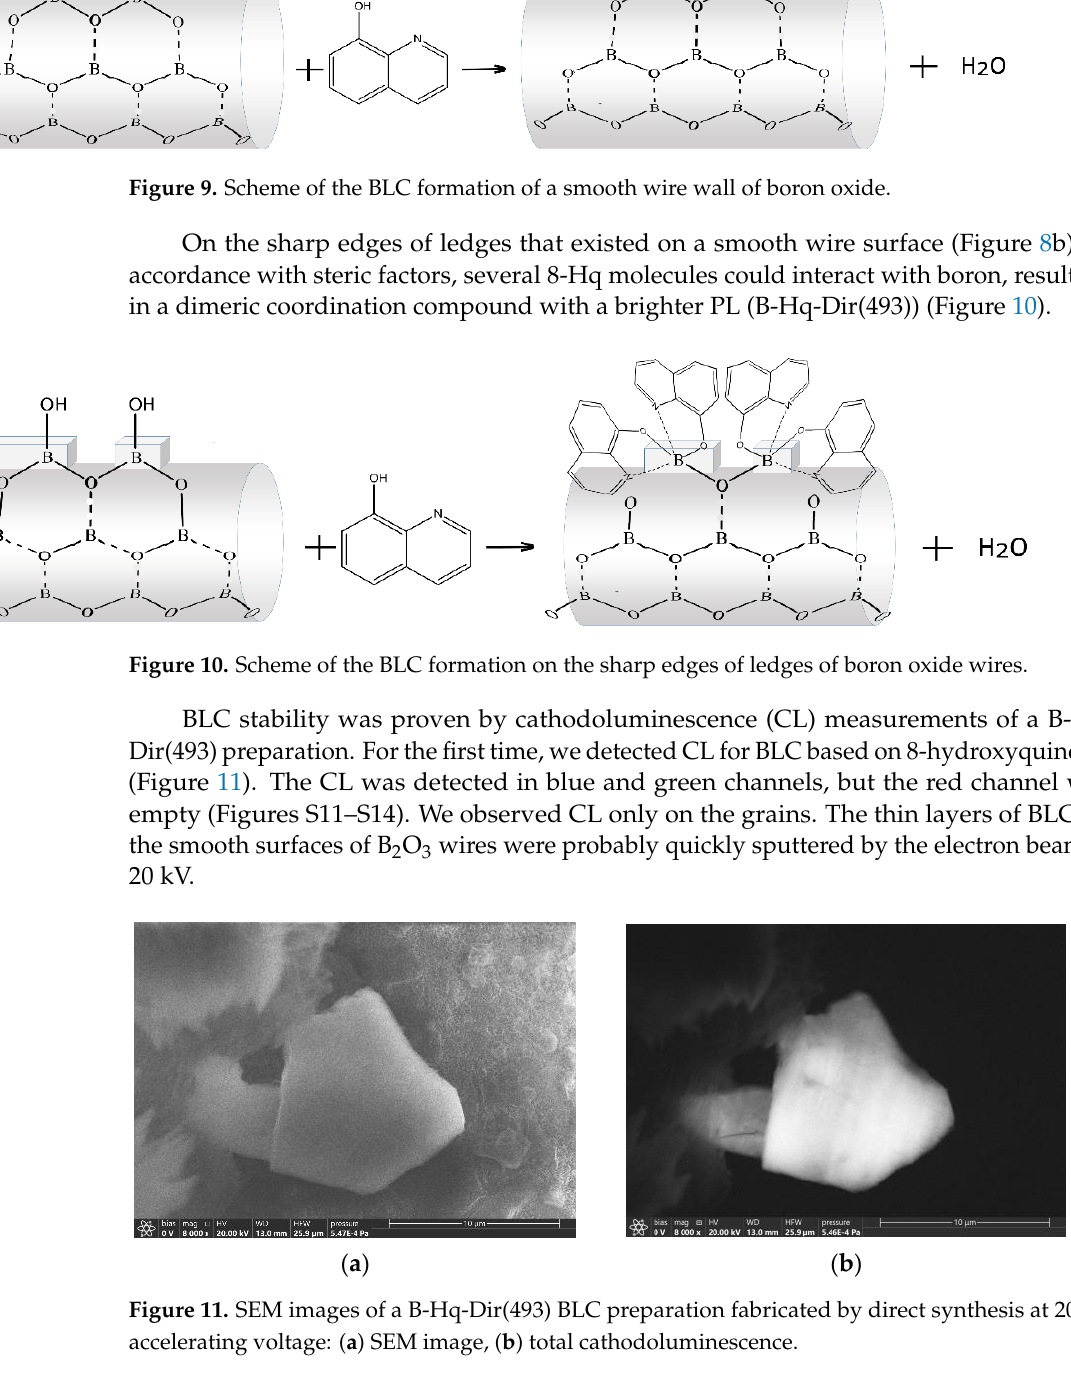
( c ) Figure 8. Photo of boron oxide wires ( a ) and SEM image of BLC ( b ) and silica aerogel ( c ).